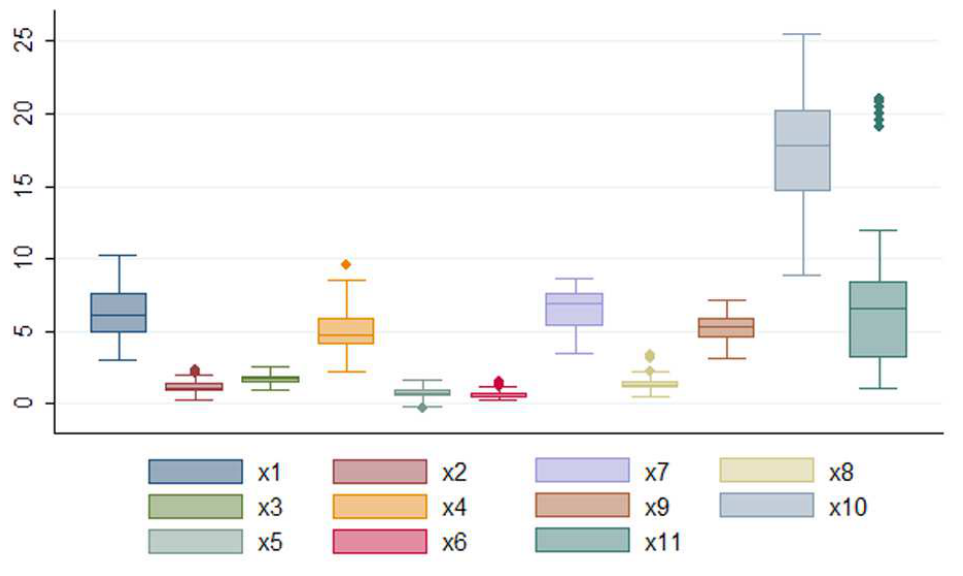
Figure 1. Boxplot of the value of government spending by item for the EU countries in